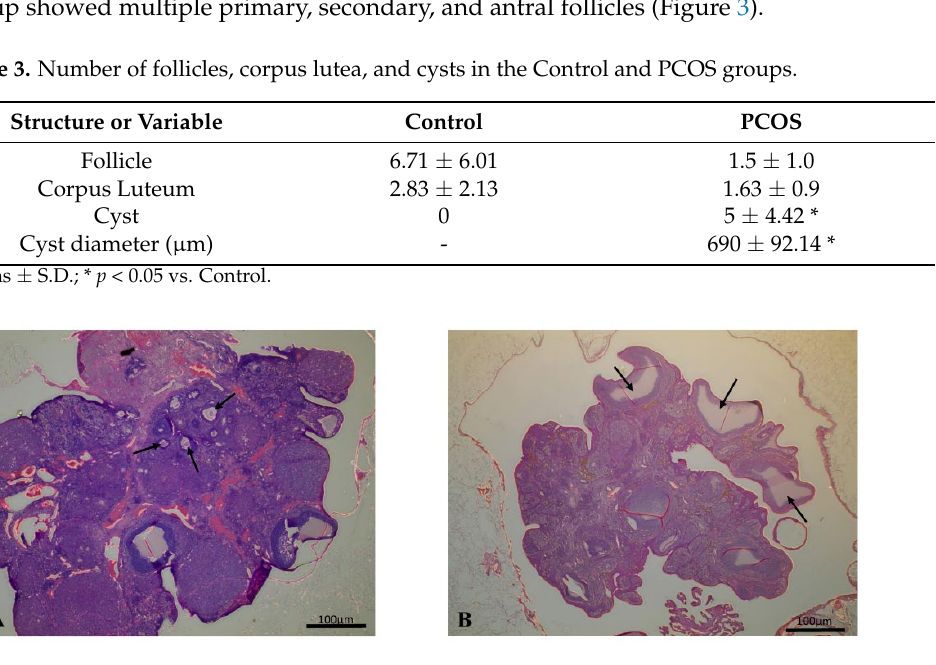
Figure 3. Representative pictures of histological appearance of the normal ovary ( A ) and the polycystic ovary ( B ). H&E staining, original magnification: 4×. Arrows show the cysts.